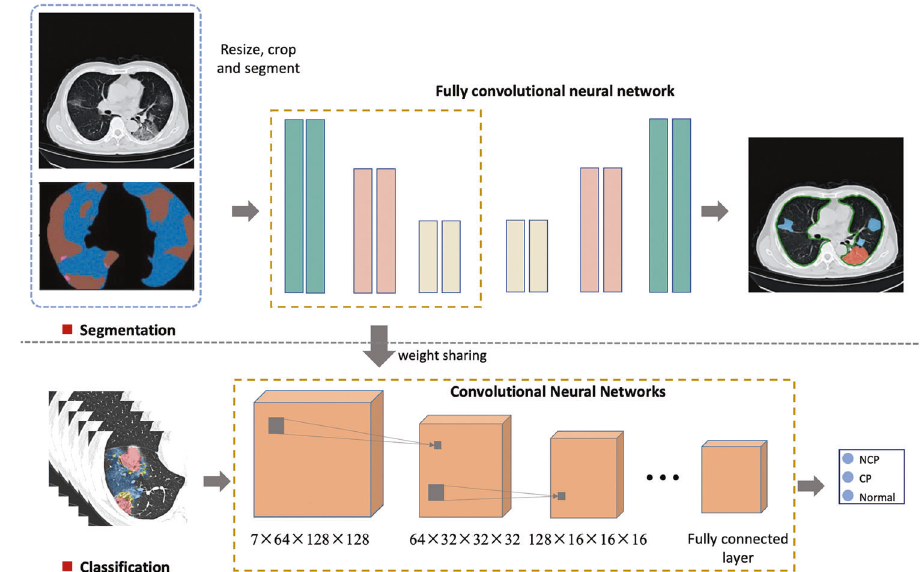
Fig. 2 Illustration of network architectures of the proposed AI diagnostic system for